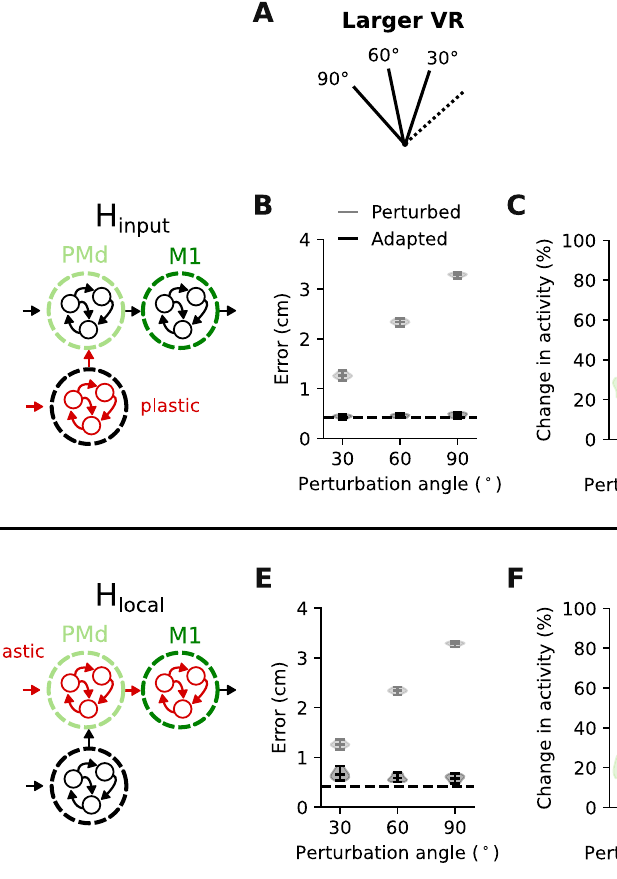
Fig. 7 | Larger visuomotor rotations allow for a better distinction between H input and H local . A To verify that the modelled perturbation does not always produce small activity changes, we tested adaptation to larger VR perturbations (60° and 90°). B Root mean squared error between target and produced hand trajectorieswithout(grey)andwithlearning(black)underH input .Dashedline,error